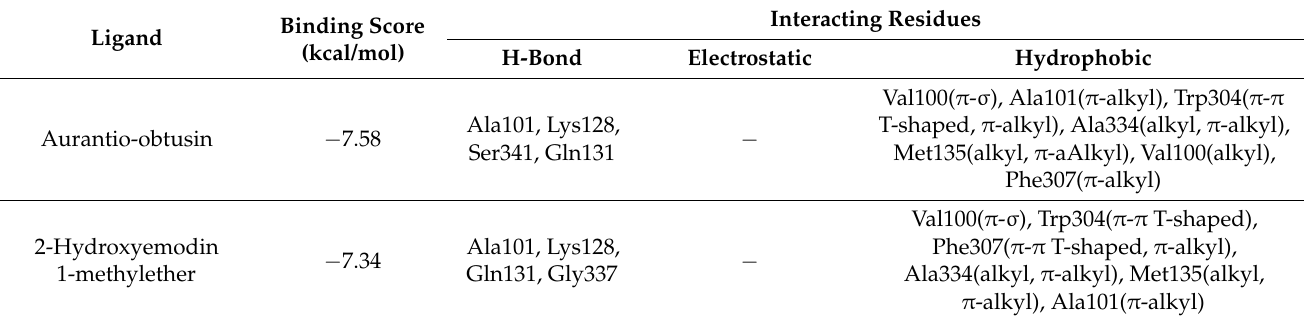
Table 2. The binding affinity of aurantio-obtusin, 2-hydroxyemodin 1-methylether, and reference ligands with human V 1A receptor using AutoDock